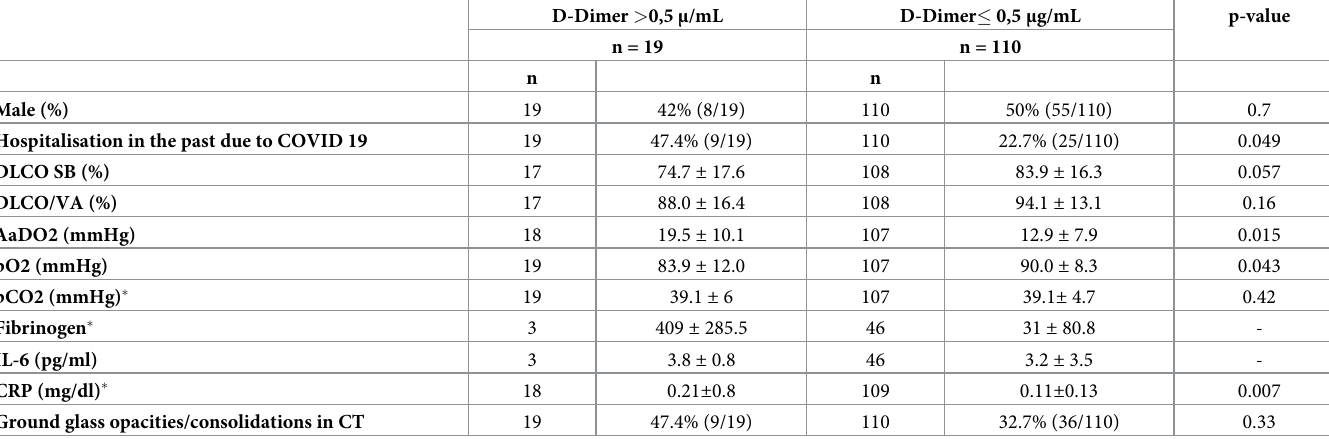
Table 2. Comparison of patients with elevated and normal D-Dimer levels following